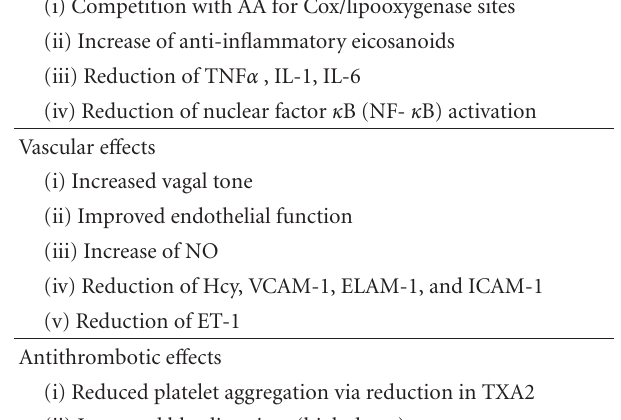
Table 1: Mechanisms and biochemical e ff ects of marine PUFA. Anti-inflammatory e ff